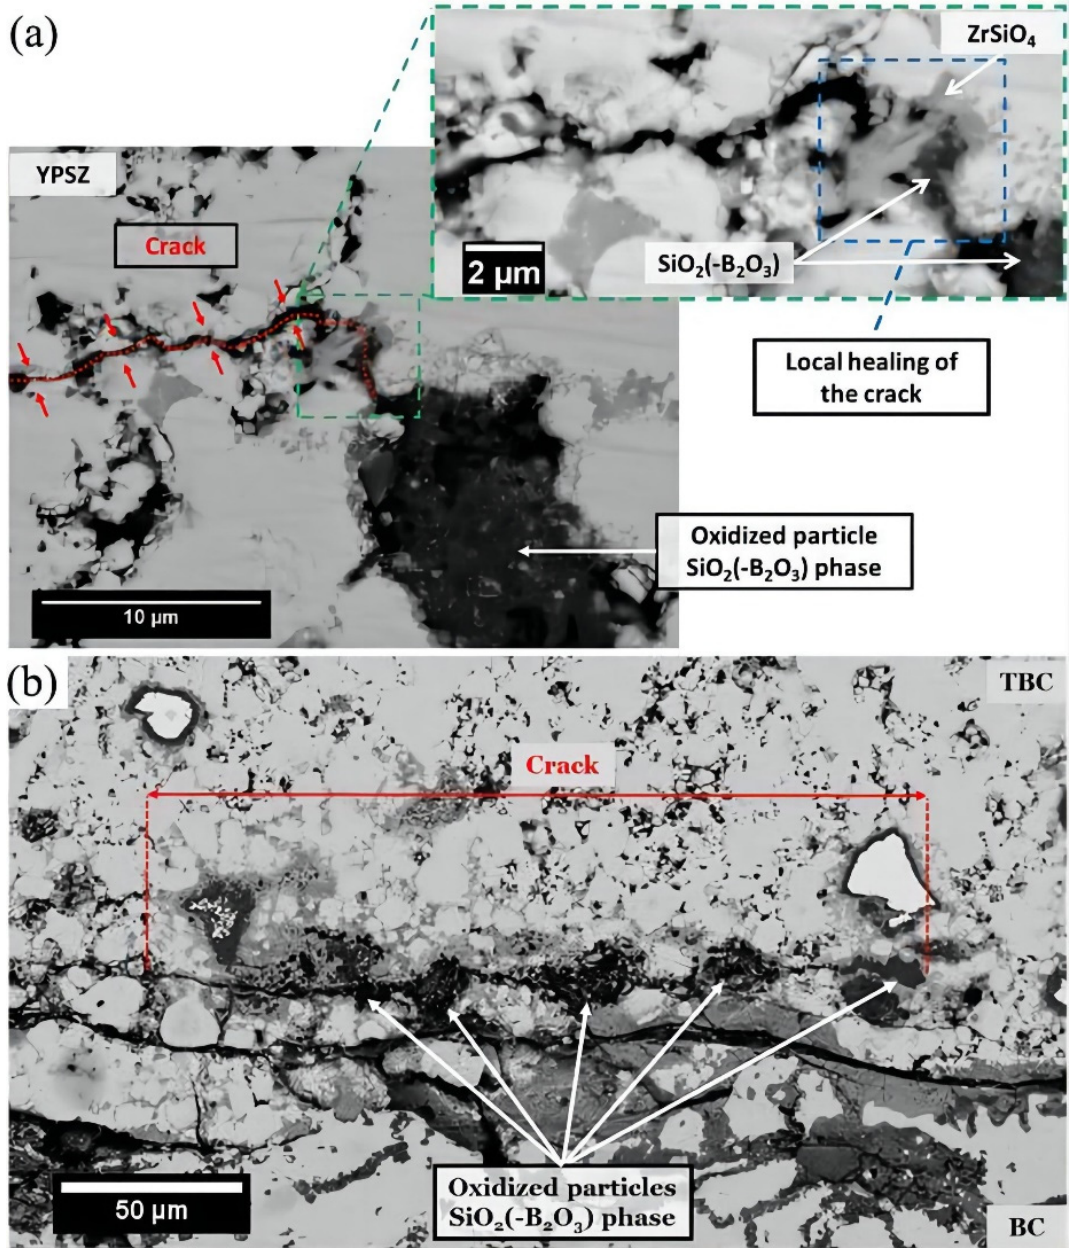
Figure 11. Image of a cross-section view of a TBC made of ( a ) a mixture of YPSZ and 5 vol% of encapsulated MoSi 2 (B)-based particles after 151 cycles of 1 h at 1100 °C and ( b ) a mixture of YPSZ powder and 10 vol% encapsulated MoSi 2 (B)-based particles sintered on a NiCrAlY-coated substrate after 1108 cumulated hot hours at 1100 °C (31 cycles) [76].